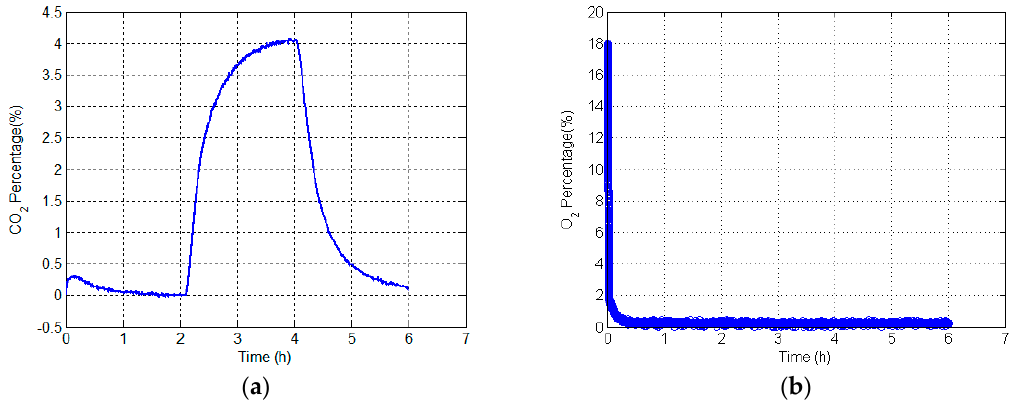
Figure 5. Response of O 2 /CO 2 analyzer during the experiment comprising 2 h of purging, 2 h of adsorption, and 2 h of desorption steps over a total period of 6 h ( a ) CO 2 concentration; ( b ) O 2 concentration. ( b ) O 2